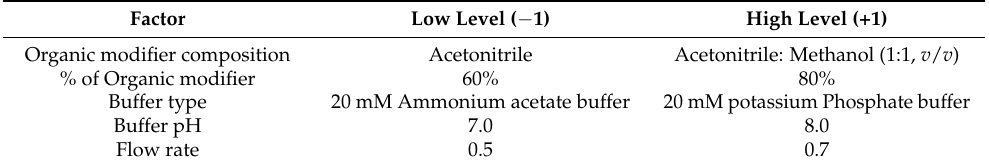
Figure 11. Chemical structure of the chiral stationary phase tris (3,5-dimethylphenyl carbamate)- derivatized cellulose immobilized on 5 μ M silica-gel in the Chiralpak IB N-5 column used for separation and chiral resolution of analytes in the current study. Cellulose consists of β (1 → 4) linked D -glucose units. Table 5. Lower and higher levels of the Initial screening design for simultaneous separation and enantiomer resolution of CAR and its metabolites.